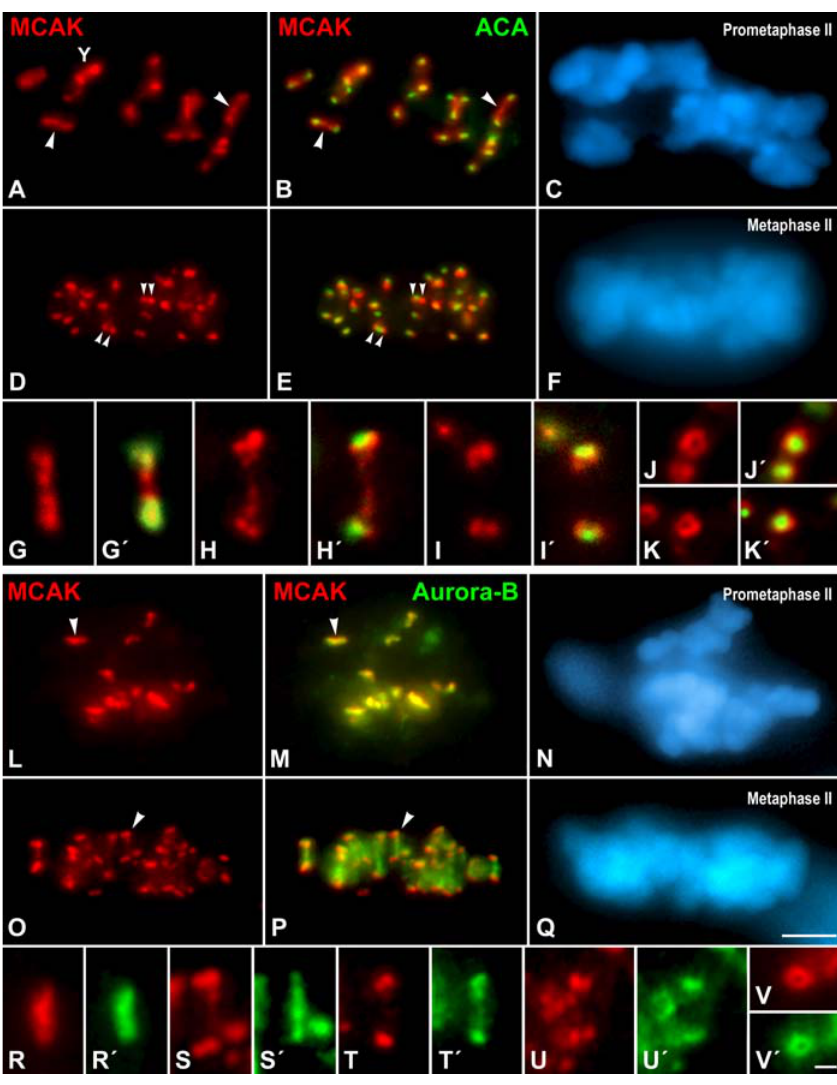
Figure 4. MCAK and Aurora-B Relocalise at Centromeres during the Prometaphase II/Metaphase II Transition MCAK is labelled in red and kinetochores (A–K 9 ) and Aurora-B (L–V 9 ) are labelled in green. In merged images colocalisation regions appear in yellow. DNA appears in blue. All images are z-projections of several focal planes throughout the spermatocytes shown. (A–C) Prometaphase II. MCAK appears as a band traversing the centromere (arrowheads) and joining sister kinetochores. The signal at the Y centromere (Y) is brighter than the autosomal ones. (D–F) Metaphase II. MCAK is detected as pairs of dots (double arrowheads) below each sister kinetochore. (G–I 9 ) Three centromeres in prometaphase II/metaphase II sequentially placed from G to I 9 . In prometaphase II MCAK appears as a band that crosses the centromere and joins sister kinetochores (G,G 9 ). With ongoing chromosome congression MCAK progressively disappears from the inner centromere domain to accumulate as a pair of dots below each sister kinetochore (H,H 9 ). When all chromosomes are aligned at the metaphase II plate, MCAK is only detected as two dots under each sister kinetochore (I,I 9 ). (J–K 9 ) Top views of two metaphase II kinetochores. Each sister kinetochore is encircled by an MCAK ring. (L–N) Prometaphase II. MCAK colocalises with Aurora-B at a band that traverses the centromere. The centromere indicated in Q (arrowhead) has been enlarged in R,S. (U–X) Metaphase II. The centromere indicated in L,M (arrowhead) has been enlarged in R,R 9 . (O–Q) Metaphase II. MCAK appears as two pairs of dots at each centromere, while Aurora-B is still present as a band that traverses the centromere. The centromere indicated in O,P (arrowhead) has been enlarged in S,S 9 . (T,T 9 ) Side view of a metaphase II centromere. MCAK is visible as two pairs of dots, whereas Aurora-B begins to concentrate at kinetochores but is still present at the inner domain. (U,U 9 ) Side view of a late metaphase II centromere. MCAK and Aurora-B colocalise as pairs of dots. (V,V 9 ) Top view of a metaphase II kinetochore. MCAK and Aurora-B colocalise as a ring. Bars, 2.5 l m (A–F,L–Q) and 0.5 l m (G–K 9 ,R–V 9